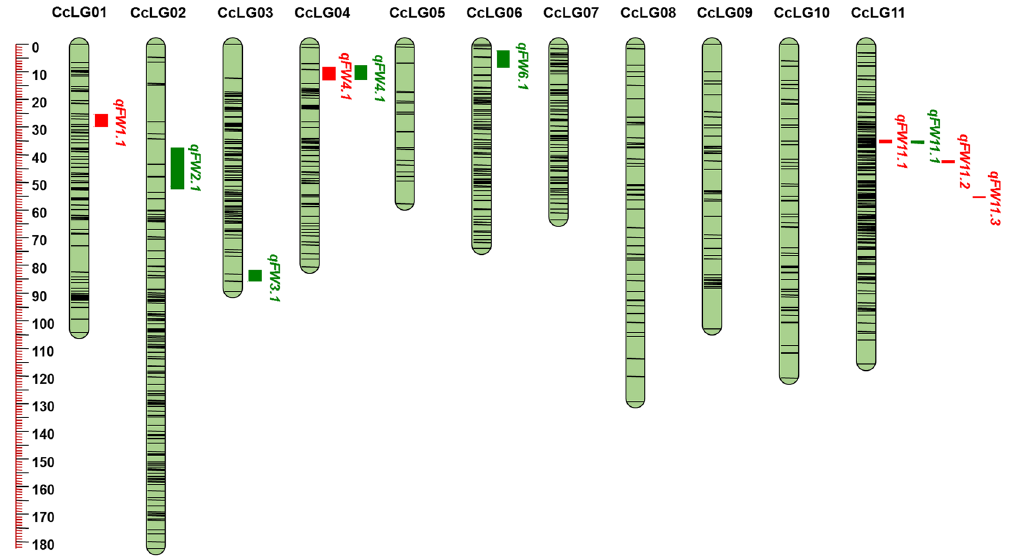
Figure 1. SNPs- based genetic map and distribution of QTLs associated with FW resistance for PRIL_A (ICPB 2049 × ICPL 99050) population. The scale is on the left indicating genetic distance (centi Morgan; cM as unit). The black lines in the linkage groups represent the genetic position of the markers. A total of six linkage groups, namely CcLG01, CcLG02, CcLG03, CcLG04, CcLG06 and CcLG11 possess eight QTLs for FW resistance. QTLs for FW resistance identified at Patancheru and Gulbarga locations were represented as a vertical bar in green and red colors,